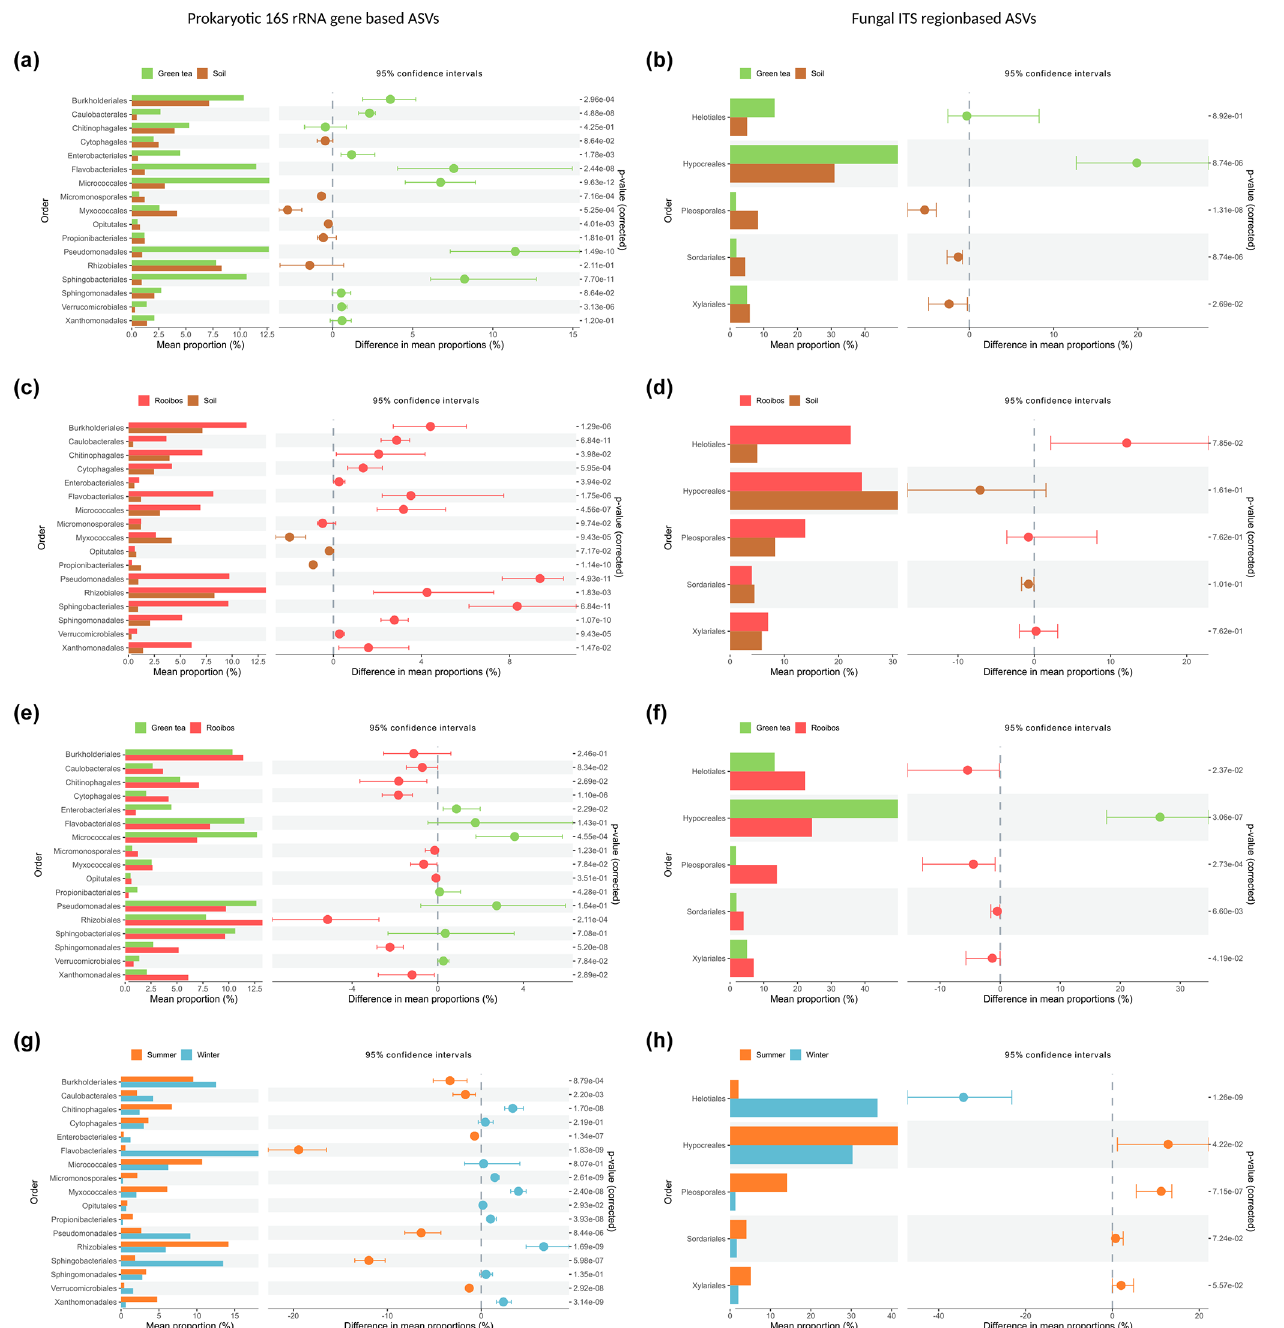
Figure 4. Comparative analysis of the relative abundance based on bacterial and fungal order profiles between soil or litter types and seasons. Samples were compared using Kruskal–Wallis rank-sum test, followed by the Mann–Whitney post hoc test, and FDR-corrected using the Benjamini–Hochberg method. Only orders with a median relative abundance of > 5% are